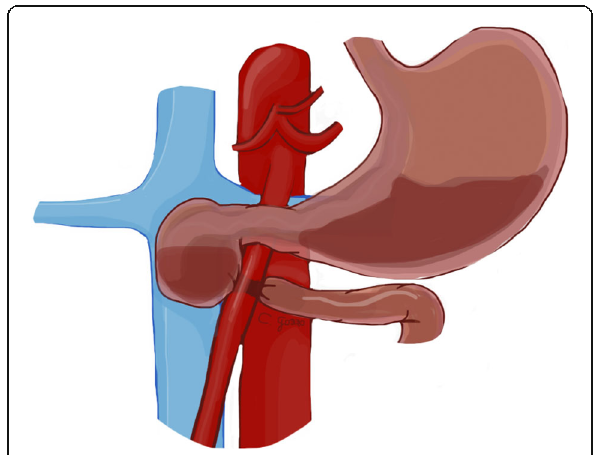
Fig. 10 Drawing illustrating the coronal view of superior mesenteric